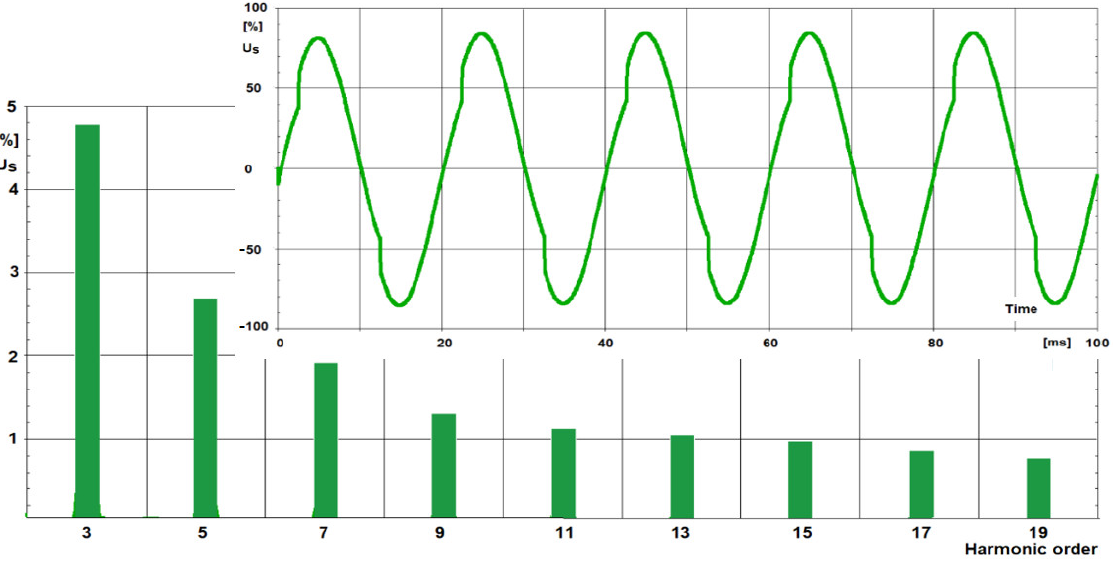
Figure 23. Oscillogram and harmonics spectrum of the supply voltage of the steel plant for S cc / S trc =